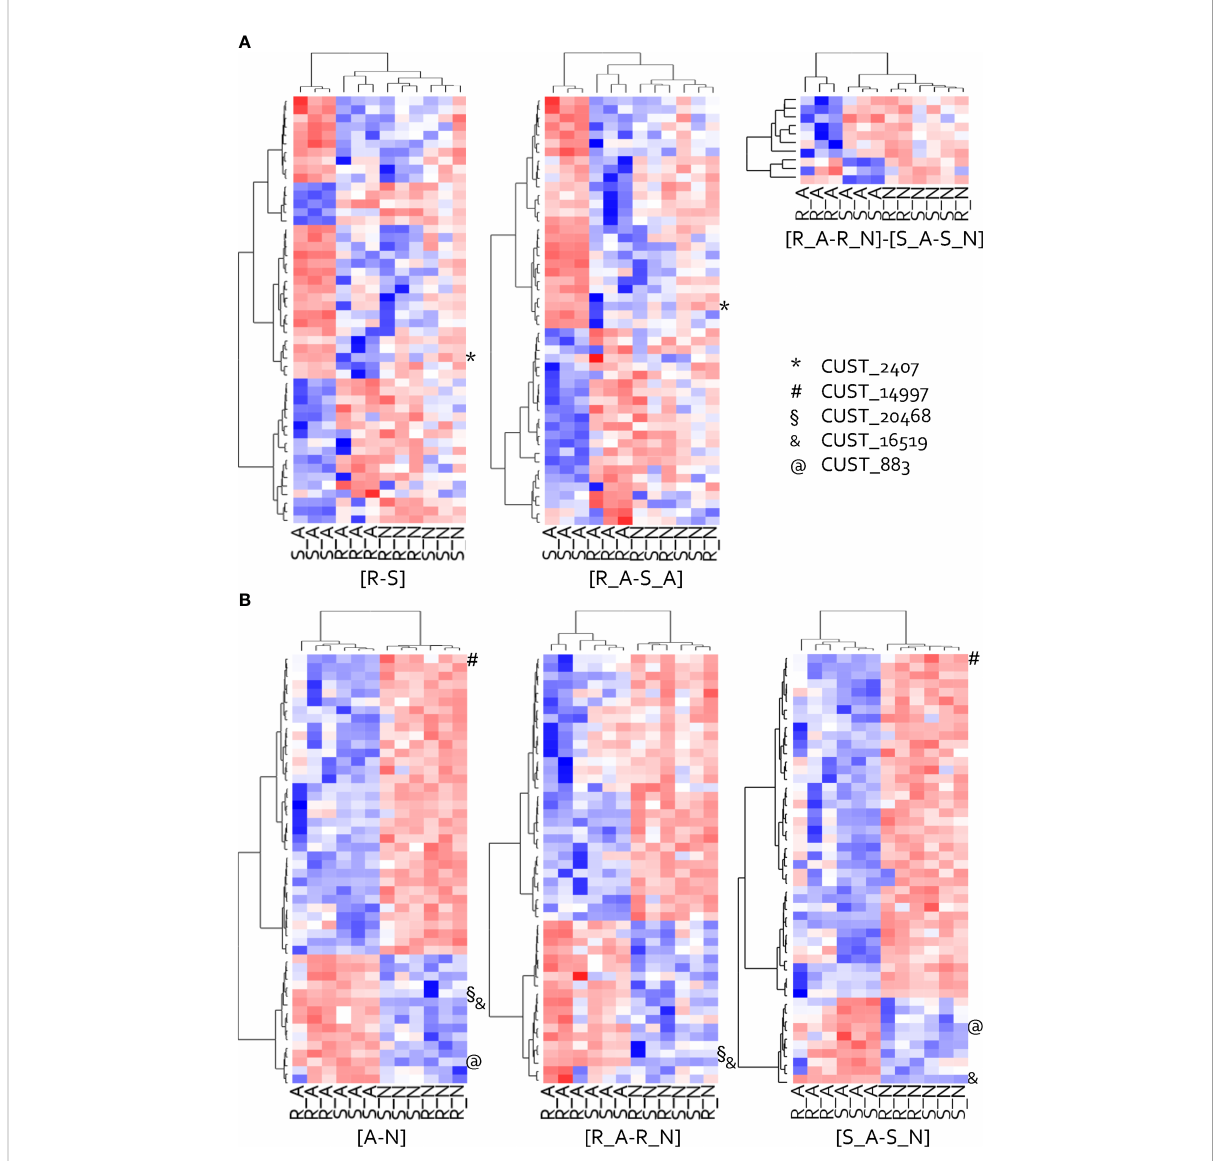
FIGURE 3 Heat map of the hierarchical clustering of the 50-top host-related (A) and isolate-related (B) DEGs. Clustering made on behavior patterns of the twelve samples are presented for each studied contrast, except for [R_ N- S_N] that counts only four DEGs. The top DEGs have been ranked on their p-values. Red represents high relative expression and blue represents low relative expression. RxLRs (CUST) are positioned on each heat